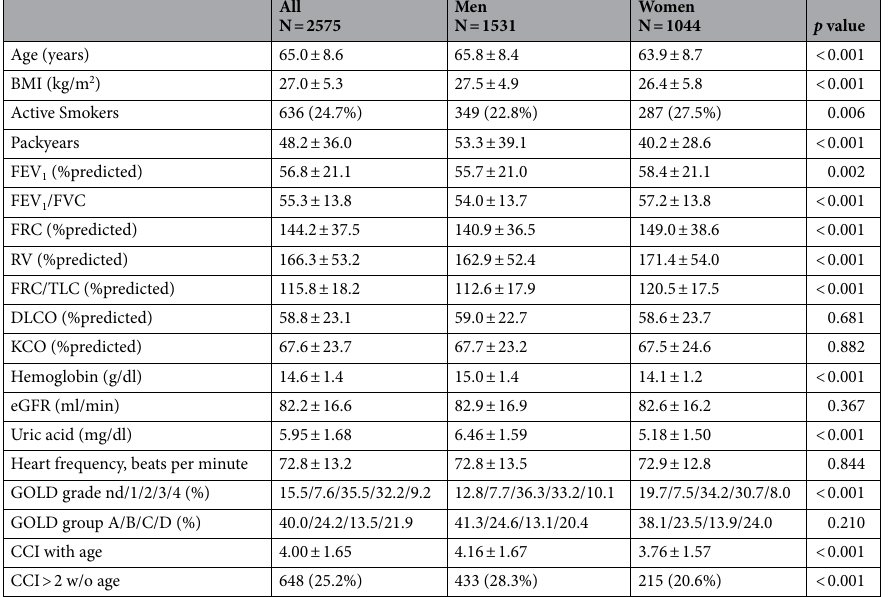
Table 1. Patient characteristics for the total study population and stratified for men and women. Mean values and standard deviations are shown, or numbers and percentages. w/o = without, nd = not defined according to GOLD criteria. CCI = Charlson Comorbidity Index, computed either including age categories as conventional, or excluding age in order to focus on the number of comorbidities. p values refer to chi-square statistics from contingency tables or unpaired t-tests, dependent on the type of